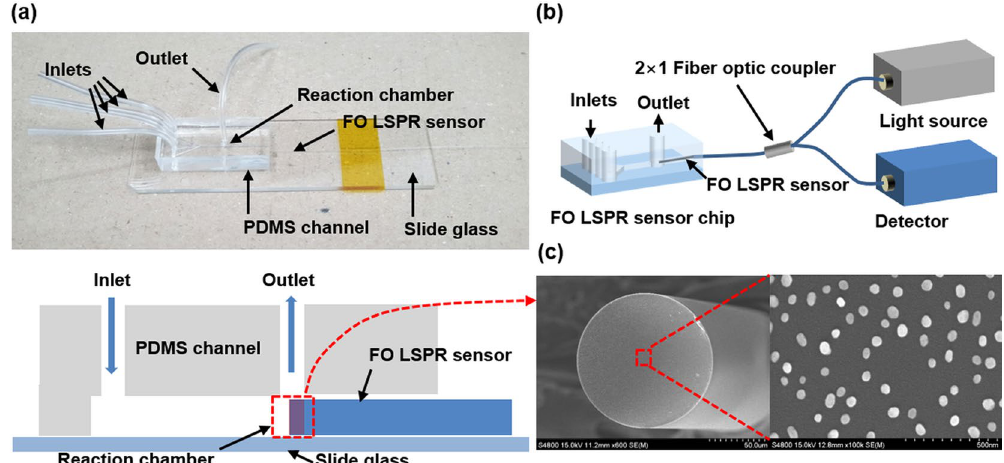
Figure 1. Fabricated FO LSPR sensor chip, optical set-up, and photograph of the sensor surface: ( a ) real picture of the sensor chip and side view, ( b ) simple optical measurement set-up, and ( c ) FE-SEM images of optical fiber end-facet with